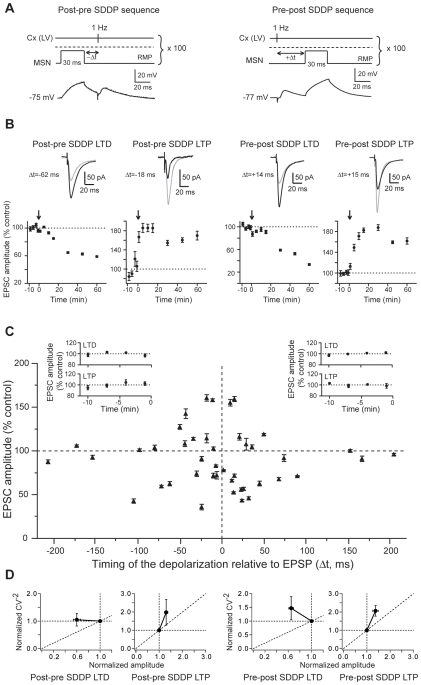
Postsynaptic subthreshold depolarizations paired with presynaptic stimulations induce long-term synaptic plasticity.(A) SDDP protocols and the corresponding raw traces of the postsynaptic MSN recordings. Brief subthreshold depolarizations were evoked in the MSN just before (post-pre SDDP sequences) or after (pre-post SDDP sequences) cortical stimulation (100 paired stimulations at 1 Hz). The dashed line indicates the action potential threshold. (B) Representative experiments of SDDP for the four observed cases. Long-term synaptic efficacy changes (illustrated by EPSCs evoked in control, black, and 60 minutes after cellular conditioning protocol, grey) were −37.5±1.4% for post-pre sdLTD (Δt = −62 ms), +60.5±4.9% for post-pre sdLTP (Δt = −18 ms), −47.5±2.0% for pre-post sdLTD (Δt = +14 ms) and +59.3±2.7% for pre-post sdLTP (Δt = +15 ms) (arrows indicate the cellular conditioning protocols). (C) SDDP protocols induce bidirectional long-term synaptic plasticity (each 43 MSN is indicated by black triangle, mean±SEM measured 60 minutes after cellular conditioning protocol). Post-pre protocols induced sdLTD or sdLTP for −110<Δt<0 ms (n = 19). Pre-post protocols induced mainly sdLTD for 0<Δt<+110 ms (n = 18). No long-term plasticity occurred for Δt beyond +/−110 ms (n = 6). Inserts: Averages of normalized EPSC amplitudes recorded in control before SDDP protocols inducing post-pre sdLTD (n = 7), post-pre sdLTP (n = 8), pre-post sdLTD (n = 12) and pre-post sdLTP (n = 4). Control EPSCs amplitudes were recorded for 10 minutes (minus sign indicates time before the SDDP protocol) and displayed no significant variations. (D) Normalized CV−2 were plotted as a function of the normalized EPSC amplitude to determine the loci of the SDDP. The four graphs illustrate the CV−2 plots (from left to right) for post-pre sdLTD, post-pre sdLTP, pre-post sdLTD and pre-post sdLTP. Mean variance analysis suggest that post-pre and pre-post sdLTD has mainly a postsynaptic origin and, post-pre and pre-post sdLTP is mainly underlain by presynaptic mechanisms.